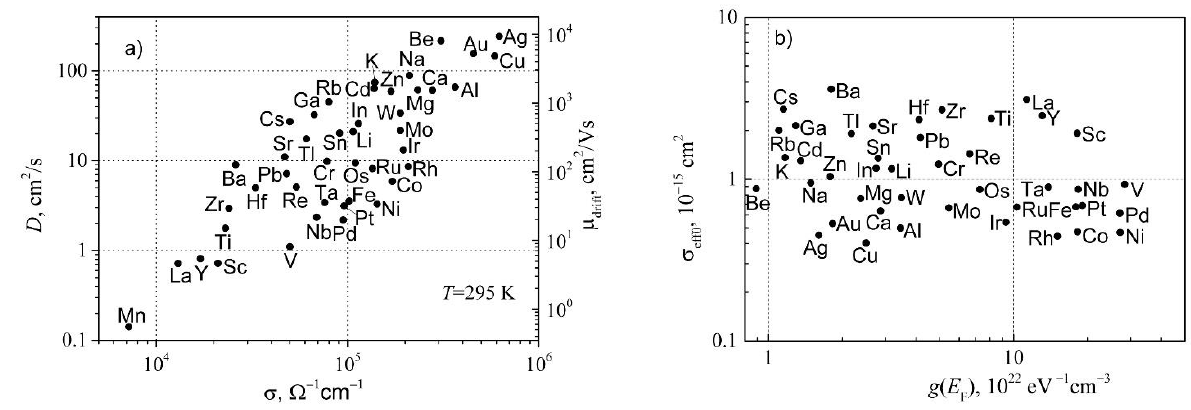
Figure 3. ( a ) Relationship between conductivity, diffusion coefficient (left scale, calculated by Equation (12) by using the experimental conductivity data) and drift mobility (right scale, calculated by Equation (10)) of the RM electrons for elemental metals at T = 295 K (the conductivity values are taken from [15,16]). ( b ) The effective scattering cross-section σ eff0 caused by electronic defects of elemental metals distribution on DOS at Fermi surface at T = 295 K. Figure 3 with permission of the Nova Science Publishers.